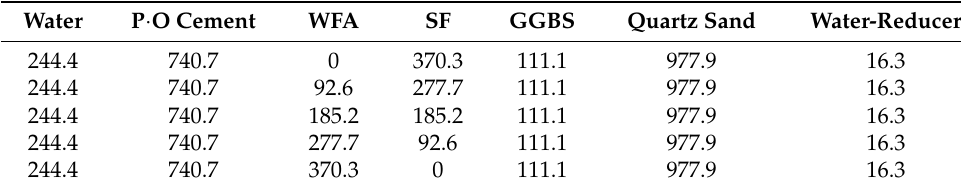
Table 2. The chemical composition of the cementitious materials (%).